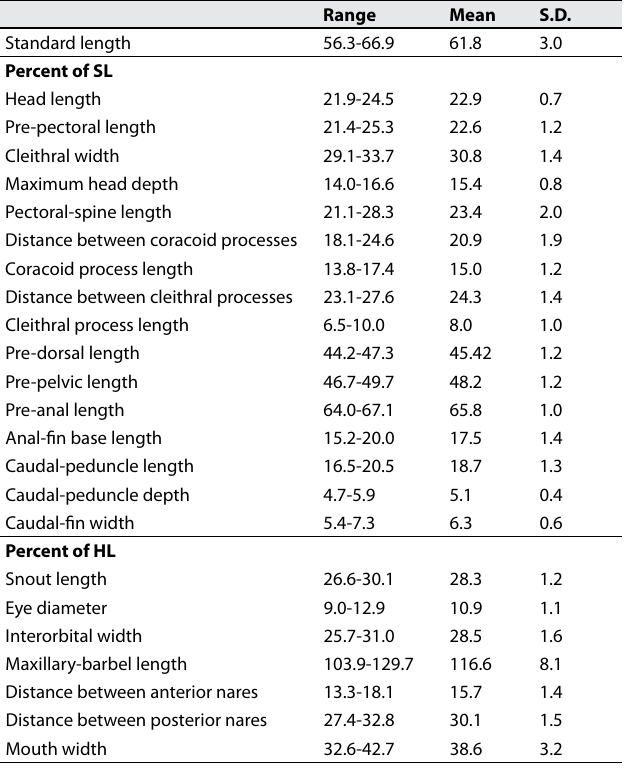
Table 1. Morphometric measurements of Bunocephalus doriae from unnamed creek, Bermejo River basin, Salta, Argentina; n = 10. Range Mean